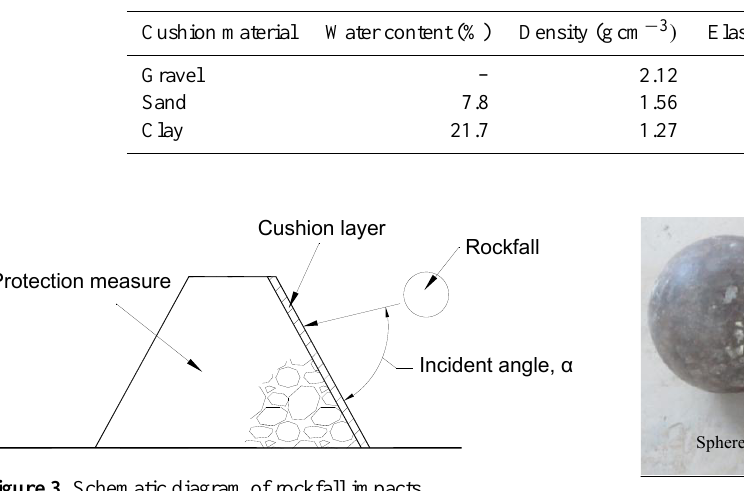
Table 1. Physical and mechanical parameters of the cushion materials.